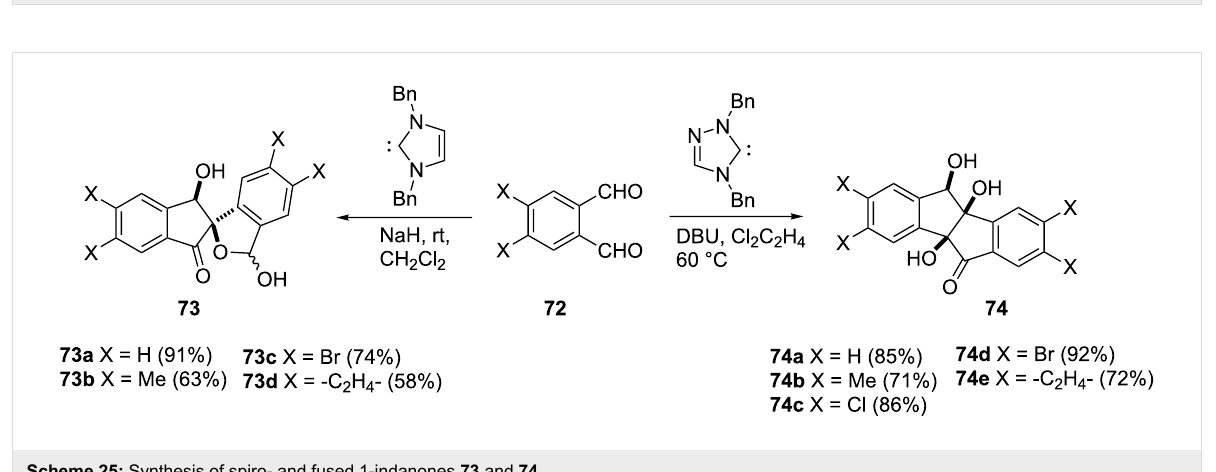
Scheme 25: Synthesis of spiro- and fused 1-indanones 73 and 74 .